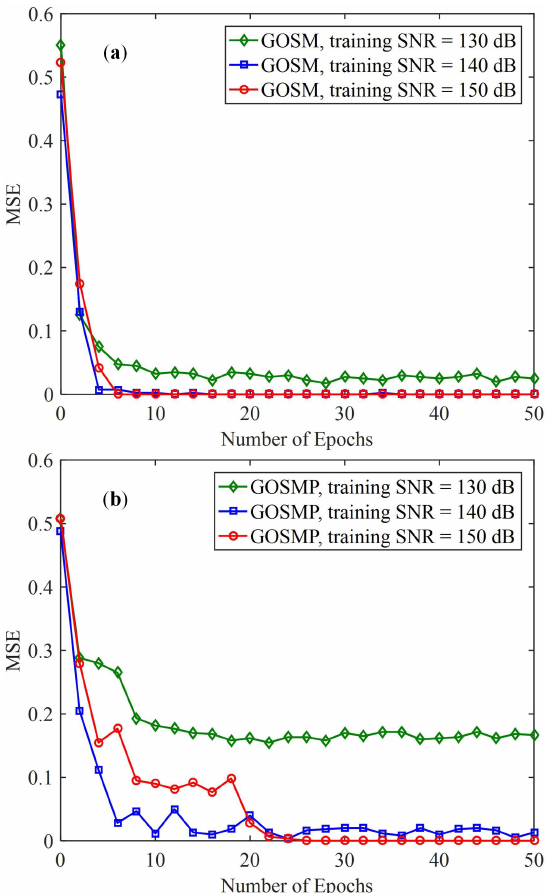
Figure 3. MSE training loss of the proposed CSI-free DNN detector with receiver located at the center of the receiving plane for ( a ) GOSM and ( b )